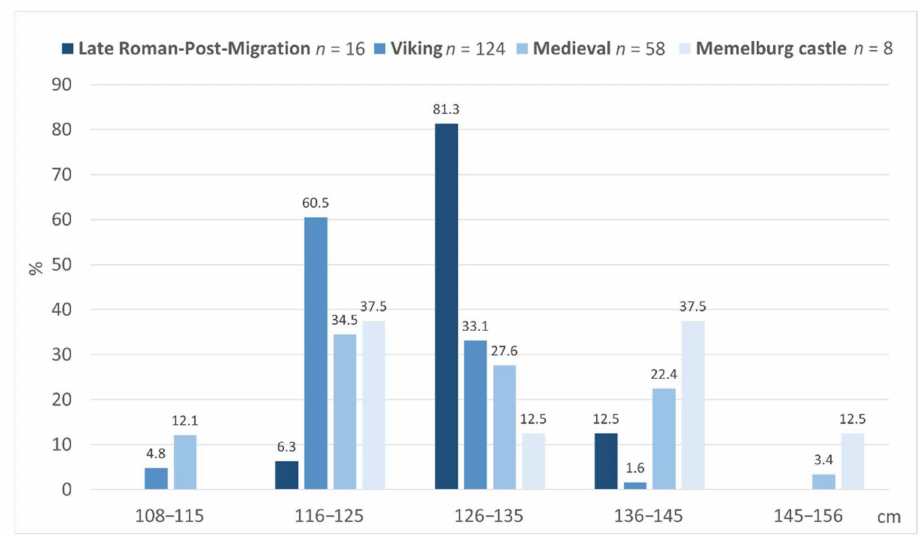
Figure 5. Withers height of